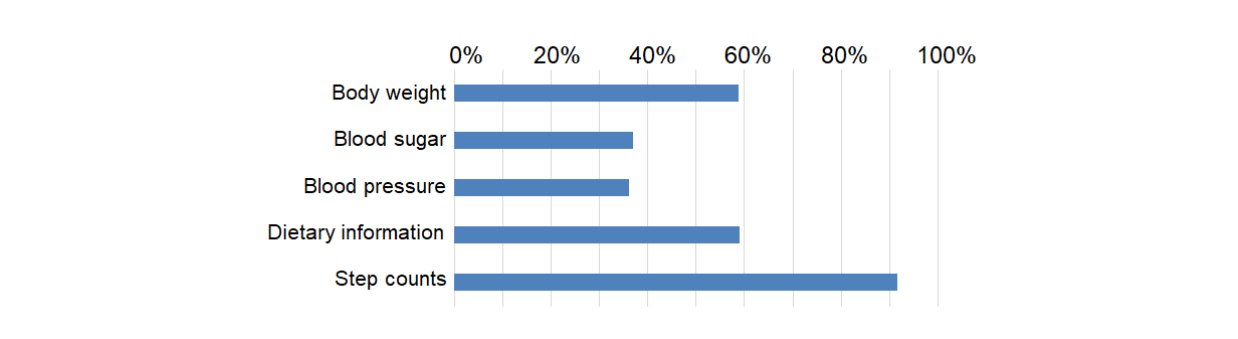
Figure 4. The proportion of users who recorded their data (n=467).